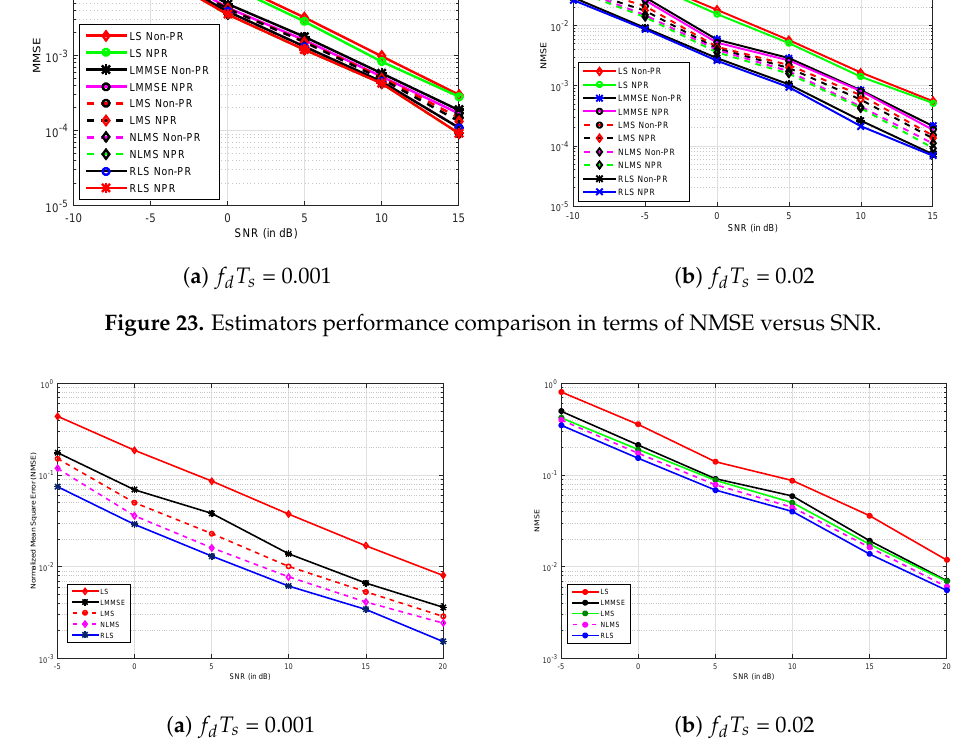
Figure 24. Estimators performance comparison in terms of NMSE versus SNR: NPR filter design.